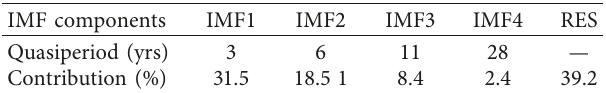
Table 4: Variance contribution rates of IMFs and RES component to WD